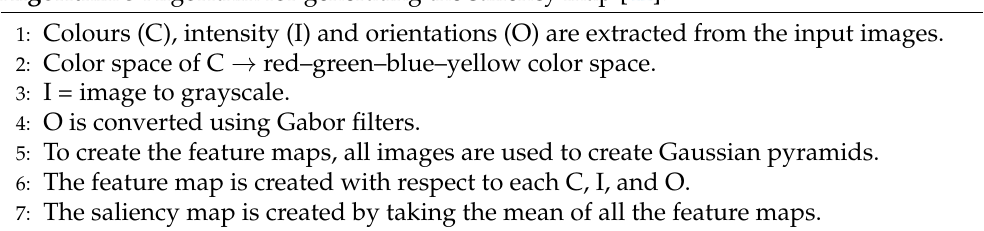
Figure 8. ( a ) Original road image from the KITTI dataset. ( b ) Saliency Map results of the ResNet-18 model. ( c ) Saliency Map results of the SegNet model. ( d ) Saliency Map results of the ResNet-50 model. Algorithm 3 Algorithm for generating the saliency map